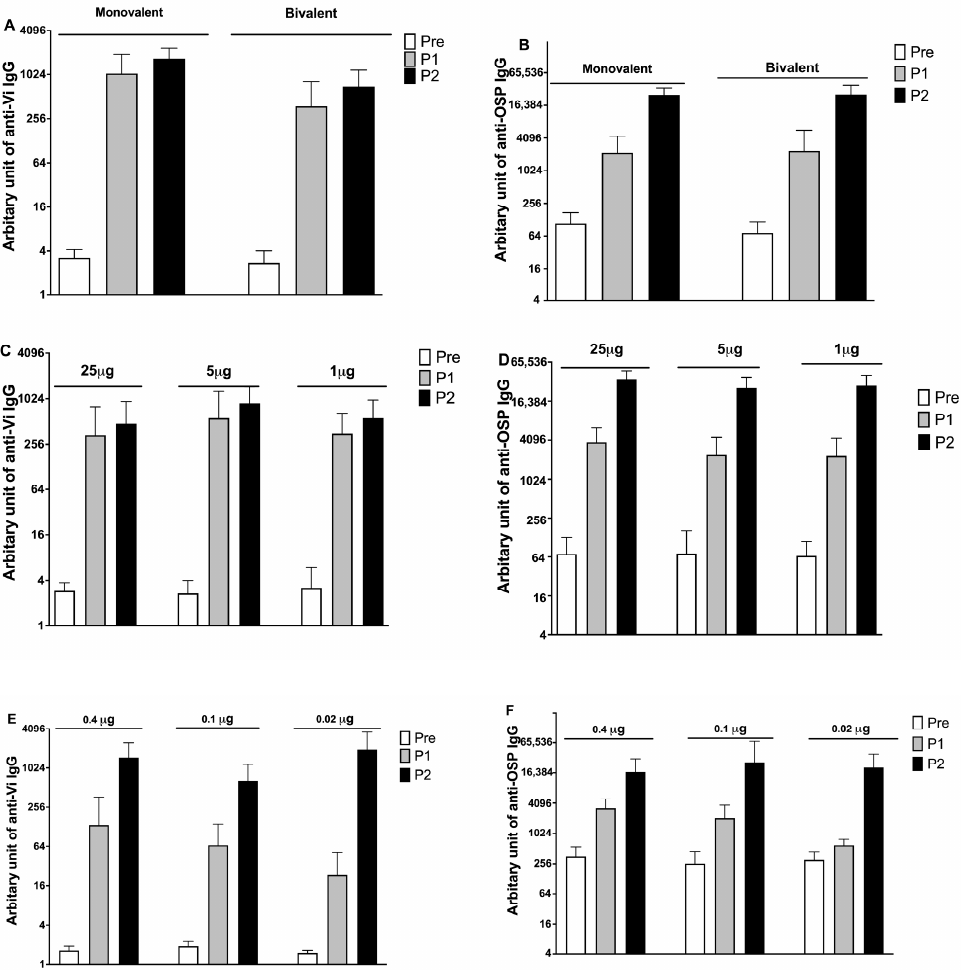
Figure 4. Immunogenicity of the monovalent and bivalent vaccines and dose responses for the bivalent vaccine. ( A ). Anti-Vi IgG titers for the monovalent and bivalent vaccines after one and two immunizations. ( B ). Anti-OSP IgG titers for the monovalent and bivalent vaccines after one and two immunizations. ( C , E ). Dose responses of Vi MAPS in rabbits. ( D , F ). Dose responses of OSP MAPS in rabbits. Each group contained ten rabbits. Bars showed geometric mean antibody titers and 95% confidence intervals.